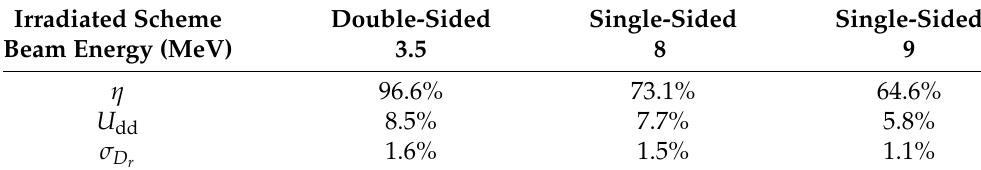
Table 3. Single- and two-sided slant irradiation results.